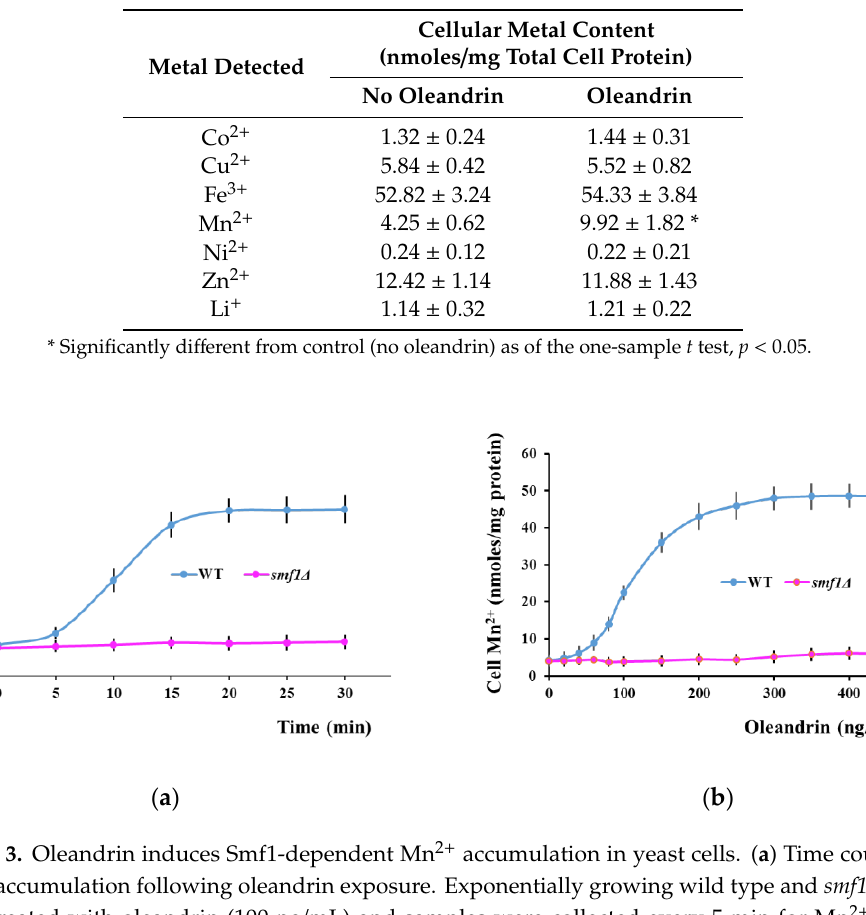
6 of 15 Table 1. Effect of oleandrin on metal content of yeast cells. Exponentially growing wild type cells